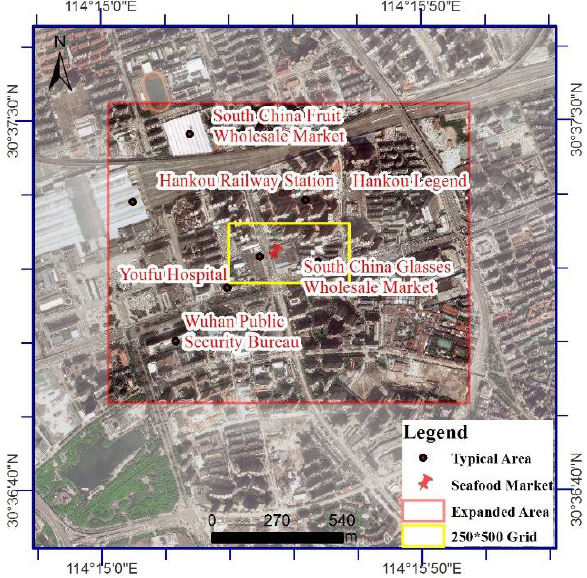
Figure 2. The study area of the South China Seafood Wholesale Market.